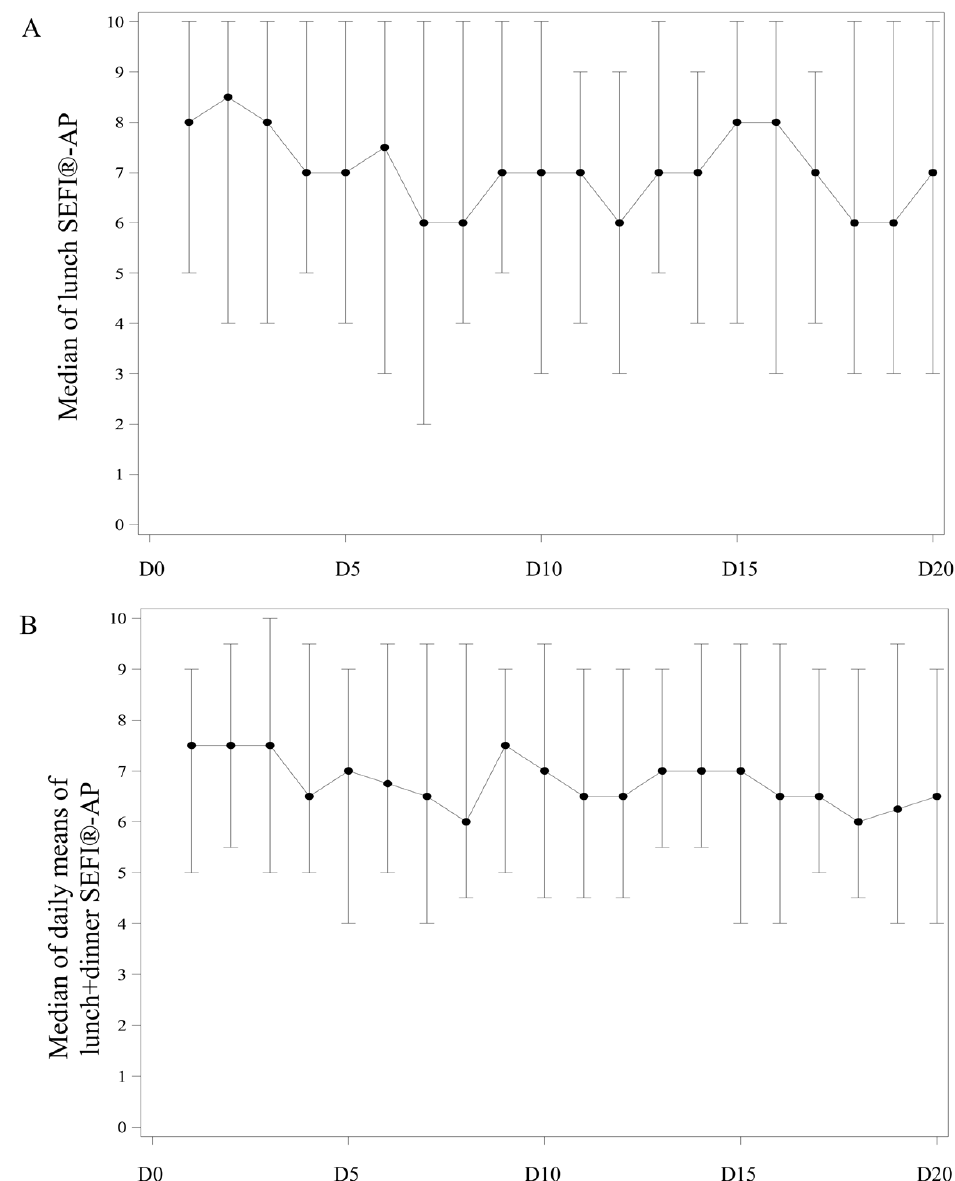
Figure 3. Evolution of the Simple Evaluation of Food Intake ® assisted by photography (SEFI ® -AP) between day (D) 0 and D 20 (n = 70). ( A ) Median SEFI ® of lunch. ( B ) Median SEFI ® -AP of the means of daily lunch and dinner. Each bar represents median and interquartile of the SEFI ® -AP score ranging from 0 to 10 each day from D0 to D20. Table 3. Median values of the Simple Evaluation of Food Intake ® assisted by photography (SEFI ® - AP) evaluated from lunch or lunch + dinner according to the follow-up period.